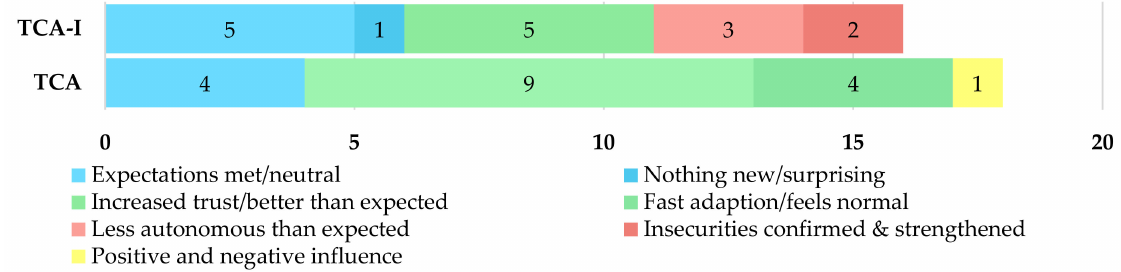
Figure 14. Attitude towards the AS and AVs in general: Distribution of results according to test condition. (Interview question